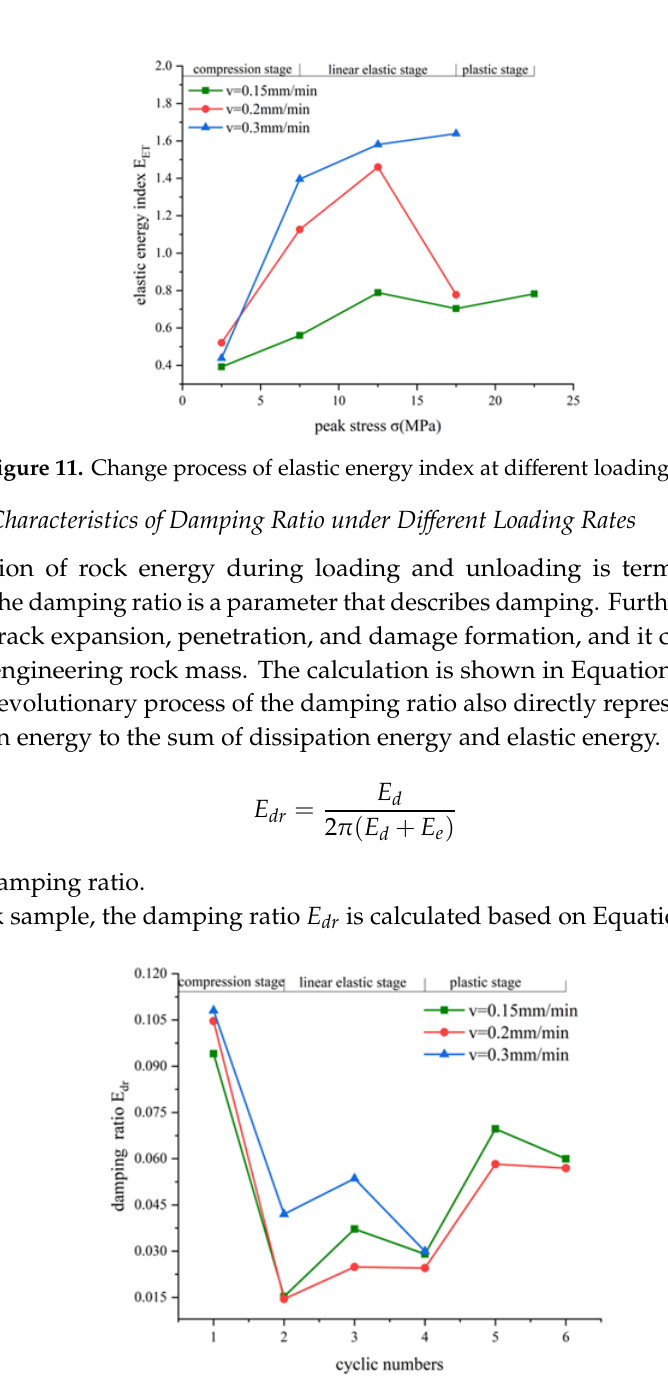
( b ) Figure 10. Change process of dissipation energy and input energy at different loading rates. ( a ) Dissipation energy (I: stable increase, II: accelerated increase, III: different degrees of increase); and ( b ) input energy (I: stable increase, II: approximate linear increase, III: large increase). It can also be seen from Figure 9a that in the linear elastic stage, the increase in plastic energy under v = 0.2mm/min is smaller than that under v = 0.15mm/min, whereas the former is larger than the latter in the plastic stage; however, dissipation energy is completely contrary to the above law in Figure 10a, owing to the fact that the rock may form shear bands in the plastic stage at a higher rate [31] (as shown in Figure 5f) when more plastic strain is produced, and more plastic energy is consumed in the rock, whereas the dissipation energy is not affected by the strain. In addition, Figures 9a and 10a also show that before the plastic stage, the increase rate of the plastic energy is approximately constant, whereas the dissipation energy exhibits a characteristic of step increase. 4.4. Evolutionary Characteristics of the Elastic Energy Index under Different Loading Rates The elastic energy index is a parameter that is used to evaluate the impact tendency of a rock. It can be directly calculated by the input energy and plastic energy [3], as expressed in Equation (6). Based on the equation, it is clear that the change characteristics of the elastic energy index can also directly represent the change in the ratio of elastic energy to plastic energy.